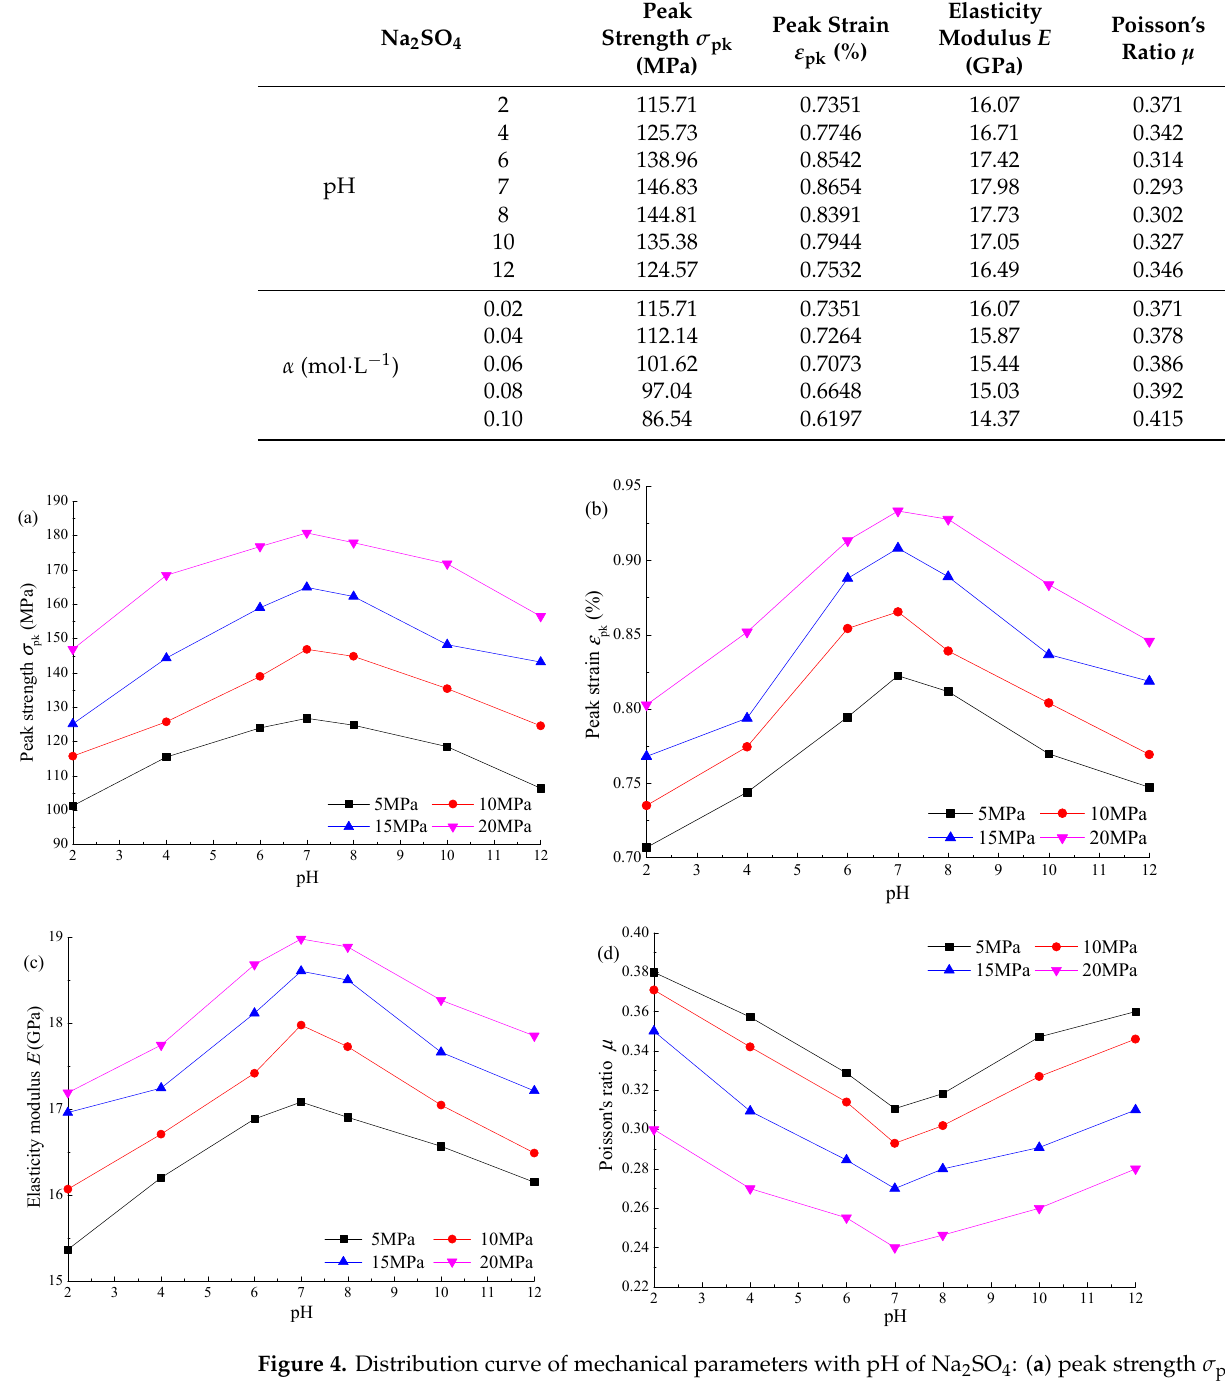
Figure 4. Distribution curve of mechanical parameters with pH of Na 2 SO 4 : ( a ) peak strength σ pk ; ( b ) peak strain ε pk ; ( c ) elasticity modulus E ; ( d ) Poisson’s ratio µ . Figure 5 shows the distribution curve of mechanical parameters of sandstone with concentration α of Na 2 SO 4 solution under different confining pressures. The peak strength, peak strain, and elastic modulus of sandstone decrease gradually with the concentration, while Poisson’s ratio shows the opposite trend. According to Table 2, when α = 0.02 mol · L − 1 , the peak strength is 115.71 MPa, the peak strain is 0.7351%, the elastic modulus is 16.07 GPa, and the Poisson’s ratio is 0.371. When α = 0.10 mol · L − 1 , the peak strength is 86.54 MPa, the peak strain is 0.6197%, the elastic modulus is 14.37 GPa, and the Poisson’s ratio is 0.415. The higher the concentration of the Na 2 SO 4 solution, the more serious the corrosion of sandstone.